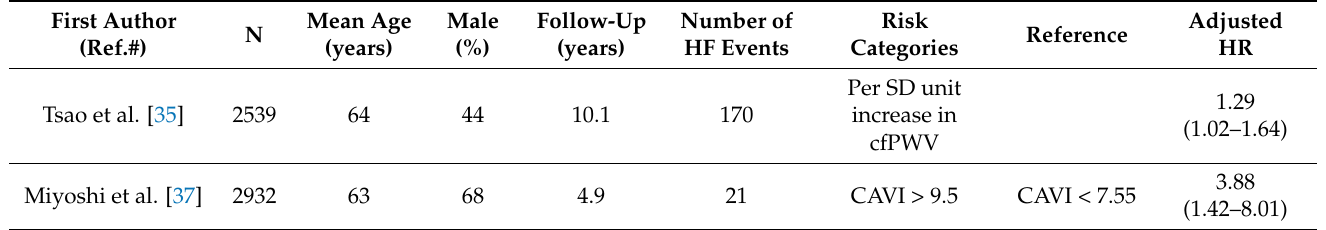
Table 3. The power of carotid–femoral pulse wave velocity/cardio-ankle vascular index as a risk predictor for heart